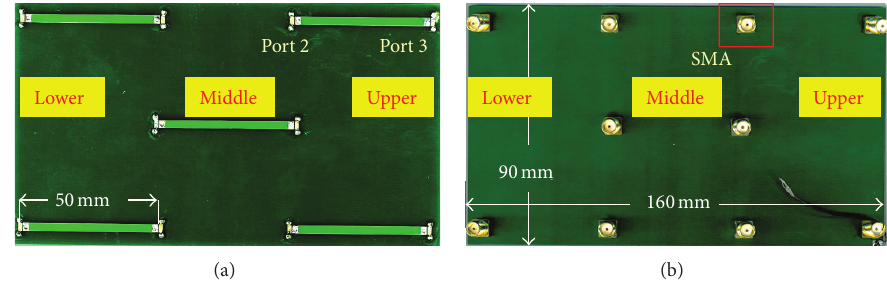
Figure 4: Photographs of the microstrip transmission lines on the board: (a) top view, (b) bottom